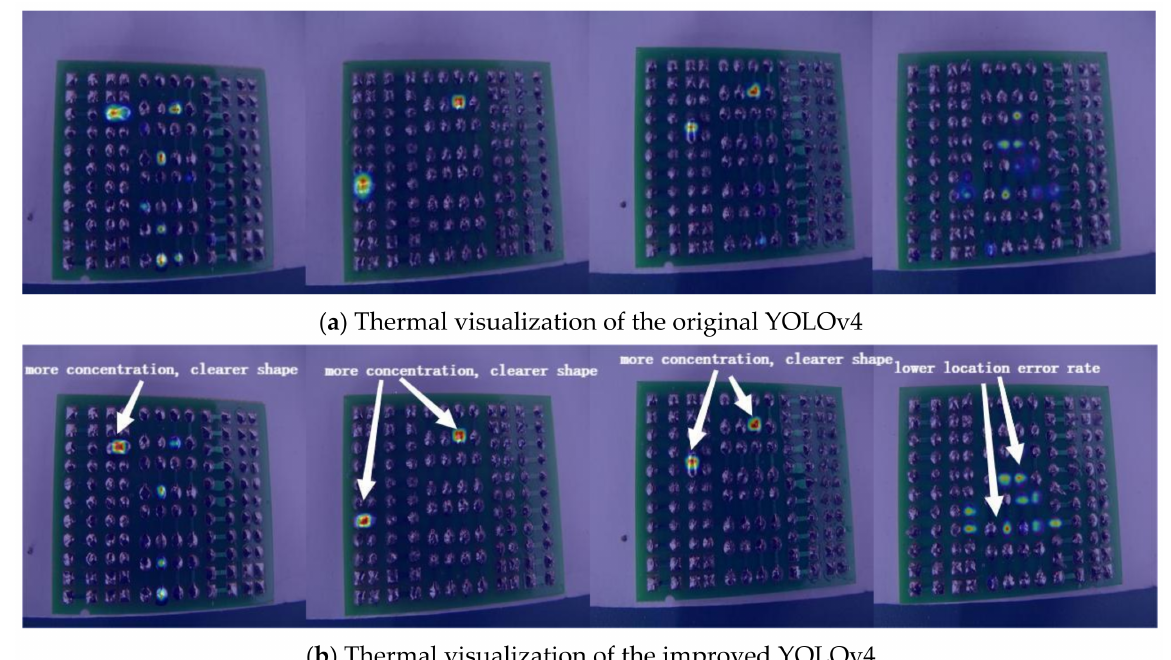
Figure 4. Visualization results of the heat